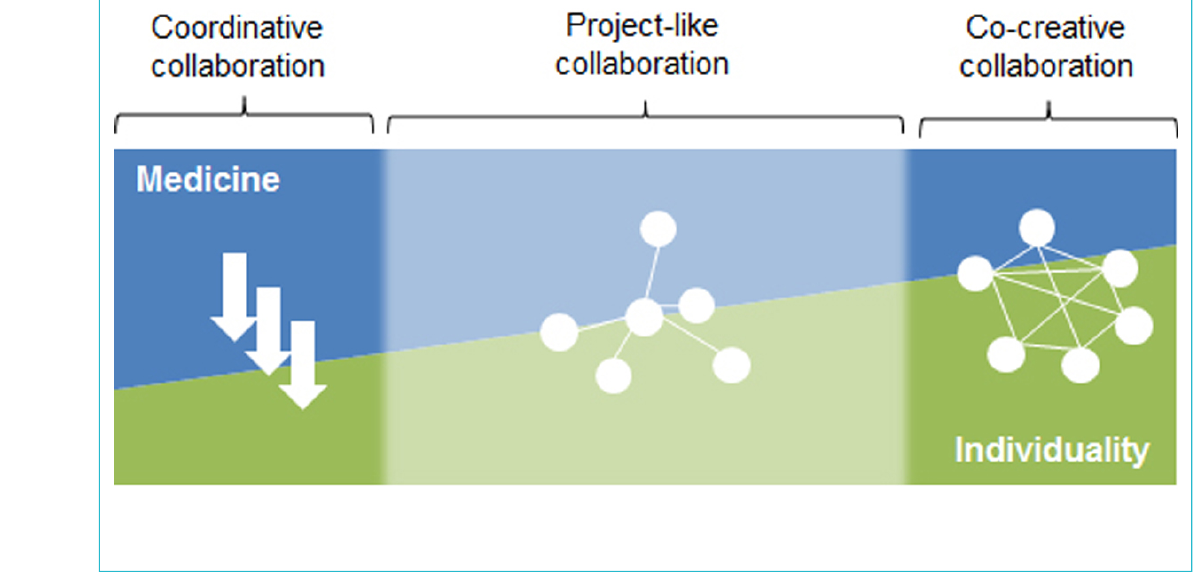
Figure 1: The spectrum, the three forms of interprofessional collaboration and the three corresponding modes of organisation (programme, hub, network). Adapted from Mintzberg and Glouberman (2001)